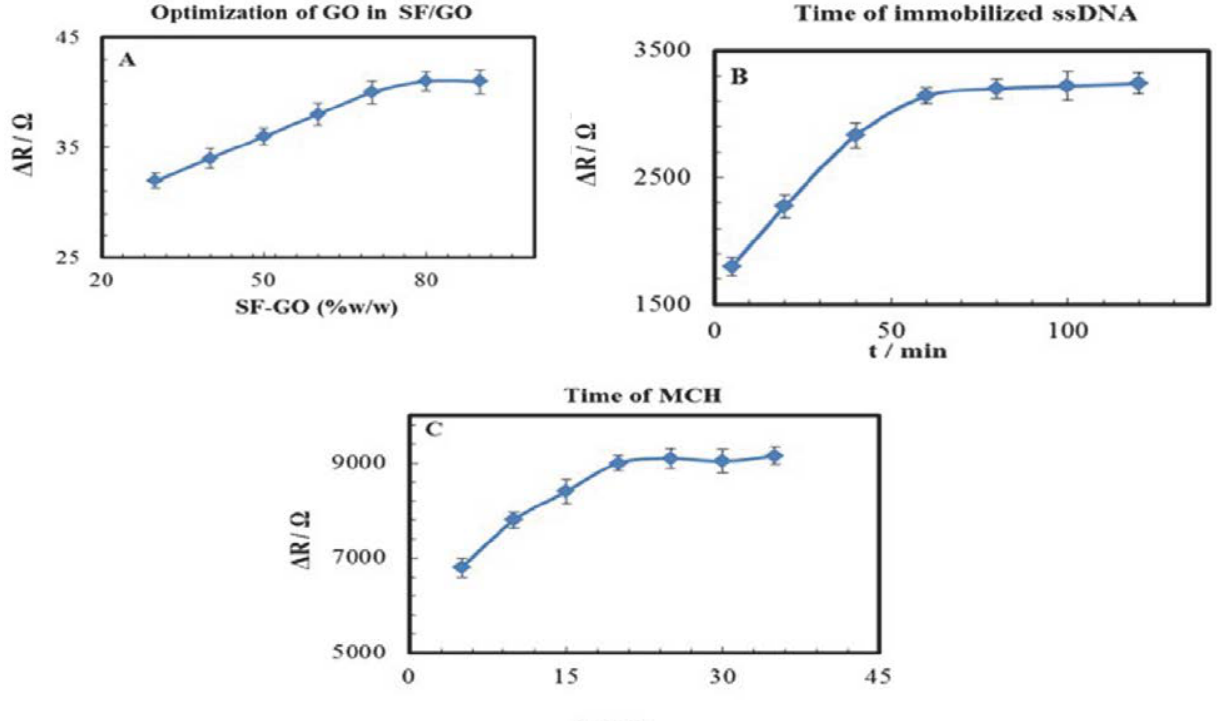
Figure 5. Optimization of operating conditions in a solution containing 0.5 mmol L –1 [Fe(CN) 6 ] 3–/4– and 0.1 mol L –1 KCl (the number of independ- ent experiments n = 3): (A) the percentages of GO in the composite of SF/GO, (B) the effect of immobilization time of ssDNA (1.0 × 10 –6 mol L –1 ), (C) the effect of MCH incubation